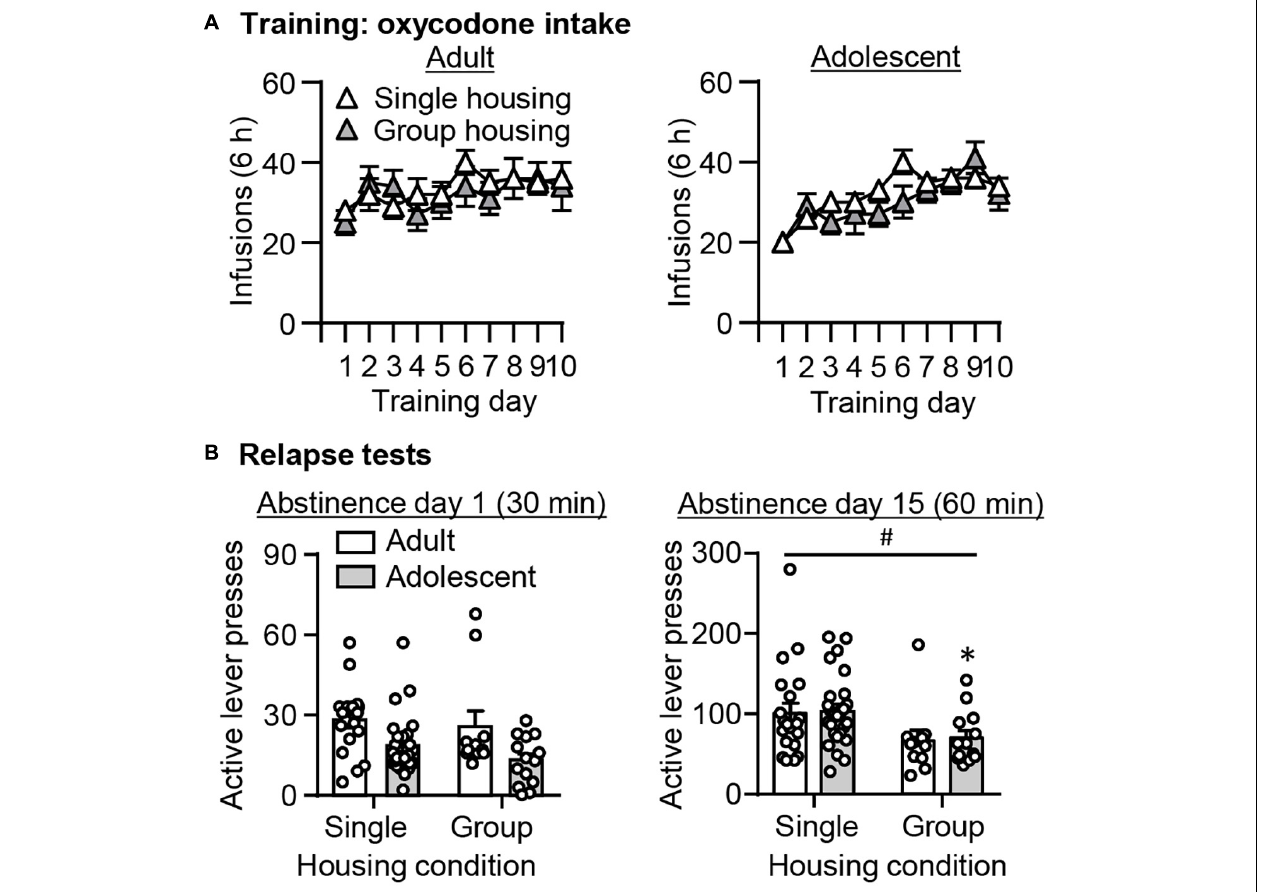
FIGURE 5 | Effect of housing condition on adult-onset and adolescent-onset oxycodone self-administration, and incubation of oxycodone craving. (A) Data are mean ± SEM number of oxycodone (0.1 mg/kg/infusion) infusions during the ten 6-h daily self-administration sessions for Adult (left) and Adolescent (right). (B) Data are mean ± SEM of active and inactive lever presses during the 30-min relapse test on abstinence day 1 (left) and the 60-min relapse test on abstinence day 15 (right). # Main effect of Housing; *Different from single-housing, p < 0.05. n =